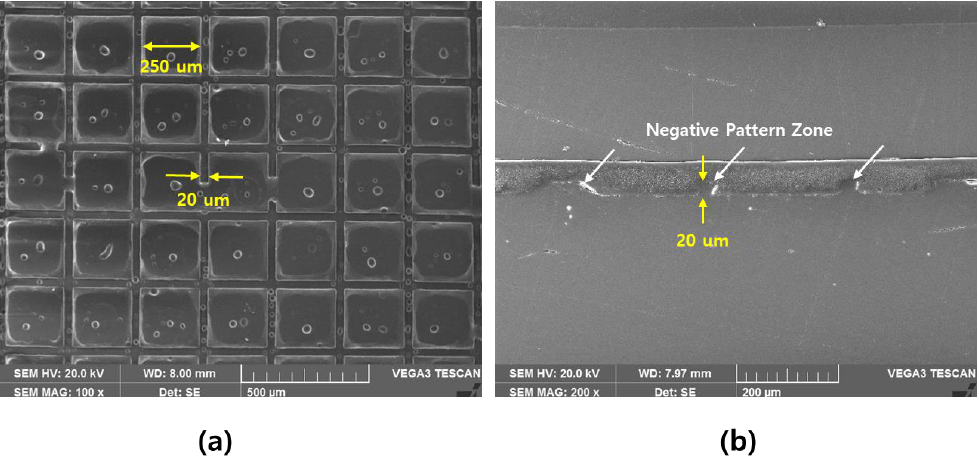
Figure 5. Enlarged image of the film patterned via imprinting. ( a ) Top view with × 100. ( b ) Sectional view with × 200.